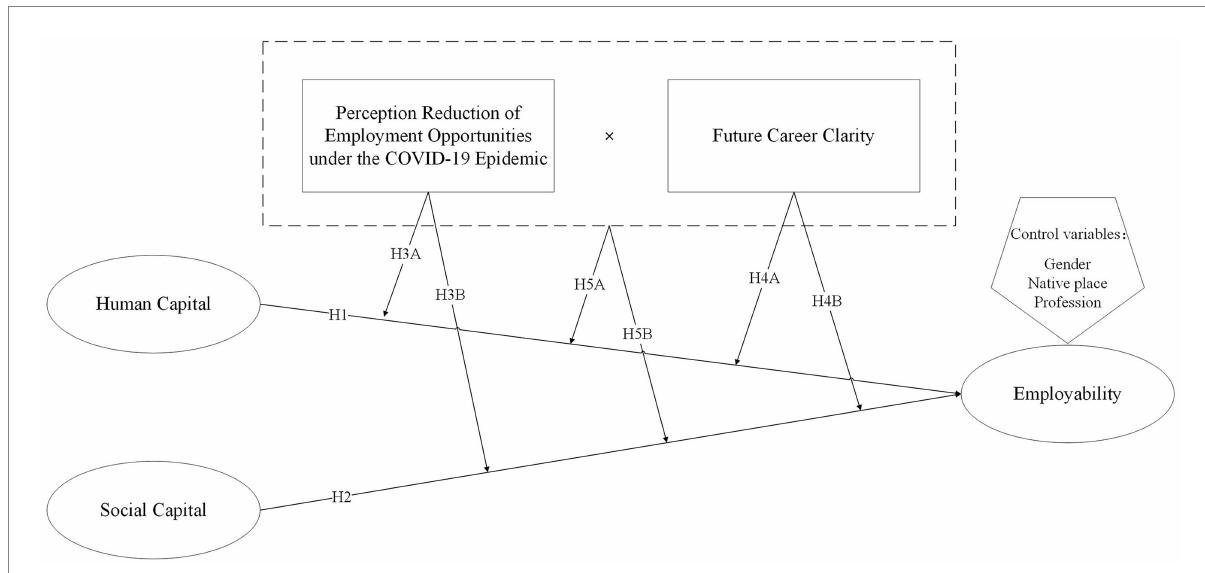
FIGURE 1 A joint adjustment model of college students’ human capital, social capital, and